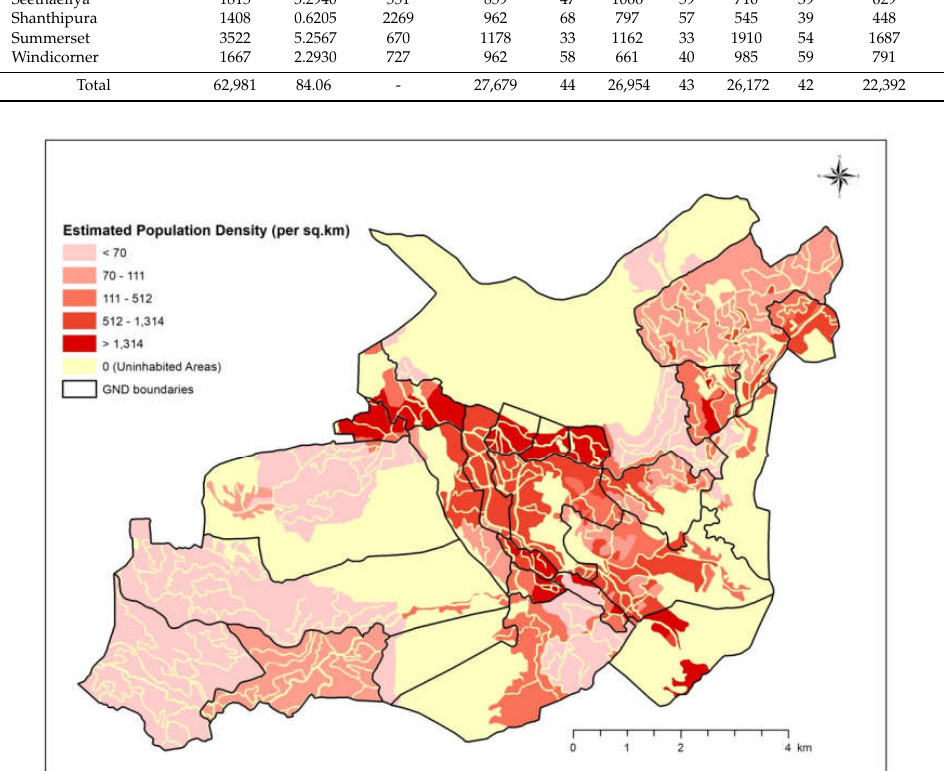
Figure 7. Population estimation using the land use-based dasymetric mapping.